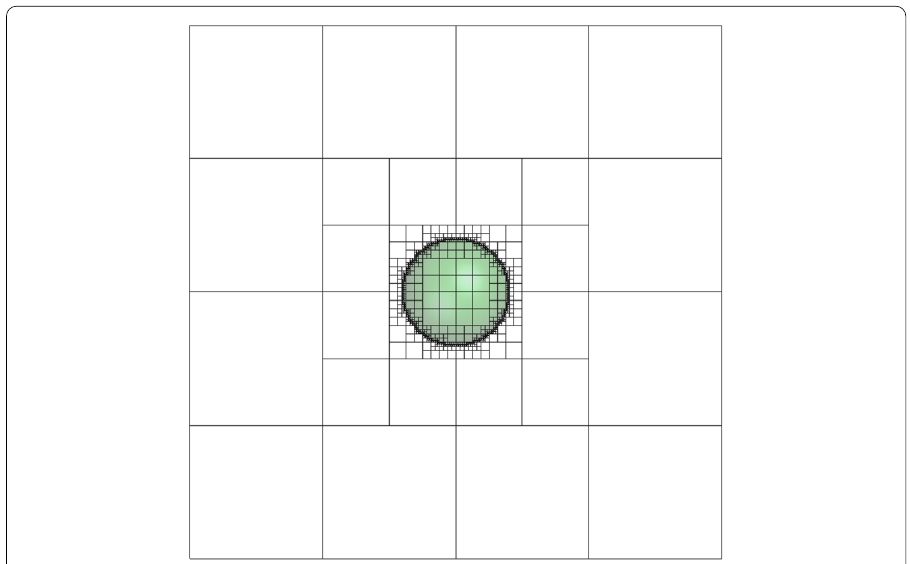
Fig. 5 Distribution of leaf cells resulting from a quadtree data structure generated around a circular geometry using eight consecutive levels of